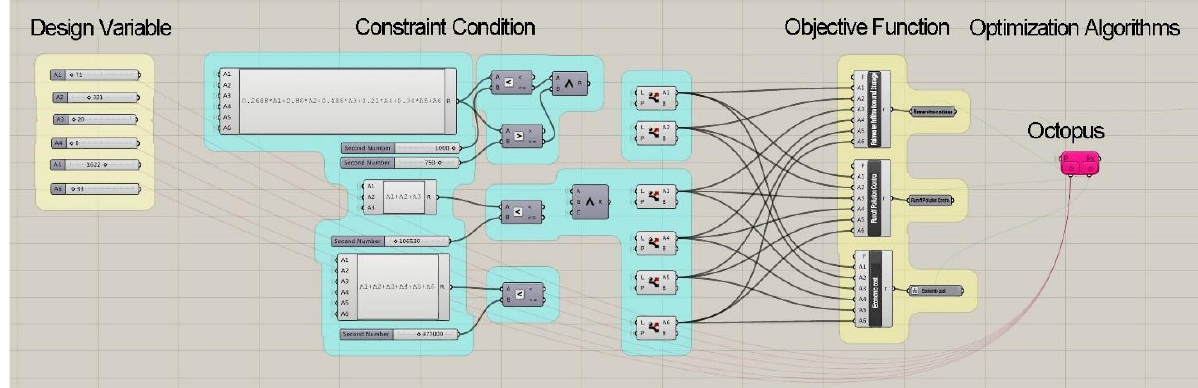
Figure 3. Connection and illustration of the Grasshopper operator for multi-objective combinatorial optimization of sponge facilities.